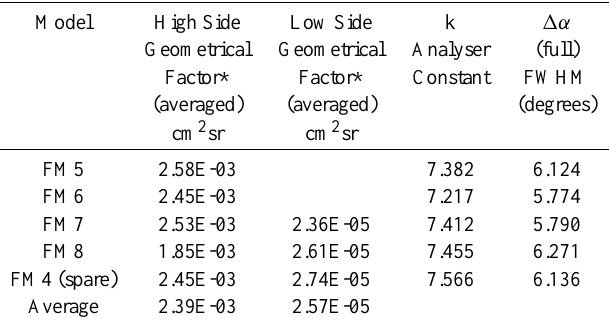
Table 4. Summary of the geometric factors for one instrument po- sition (out of 8 for High Side and 6 for Low Side), and energy and angle response for the CODIF instruments deduced from all cali- bration